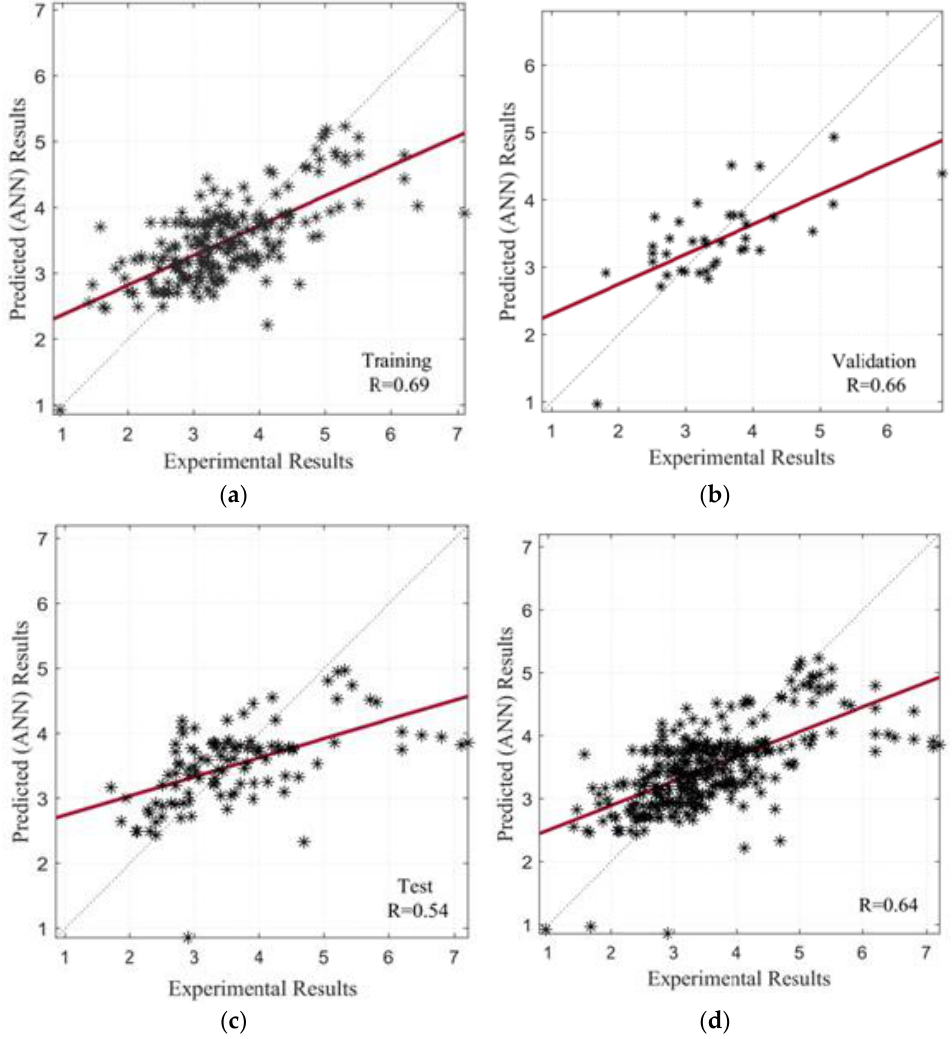
Figure 14. SCG algorithm regression graphs between the experimental and predicted tensile strength: ( a ) training; ( b ) validation; ( c ) testing, and ( d ) overall